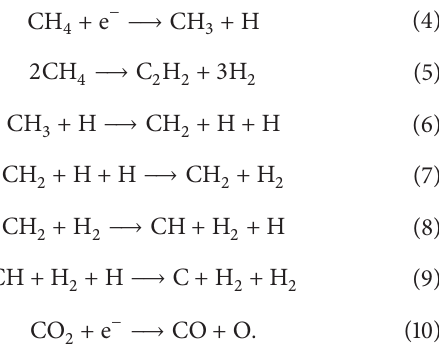
Figure 1: Experimental setup for biogas reforming: (1) CH 4 tank, (2) CO 2 tank, (3) air zero tank, (4) flow meter, (5) bubble flow meter, (6) gas filter, (7) gas chromatography, (8) power supply, (9) resistance, (10)highvoltageprobe,(11)oscilloscope,(12)glidingarcreactor,and (13)